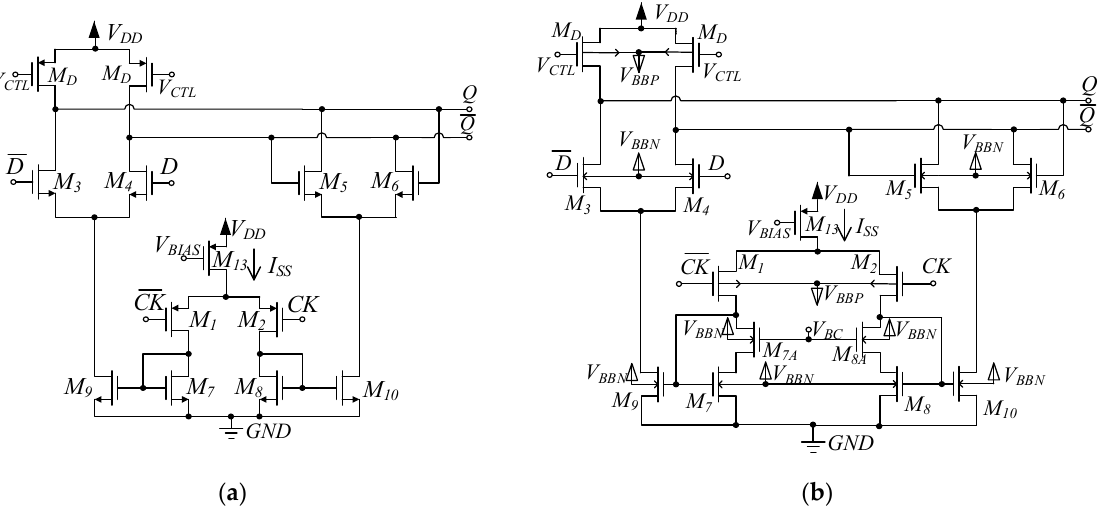
Figure 2. FMCML latch ( a ) conventional; ( b ) with FBB and improved current mirror.